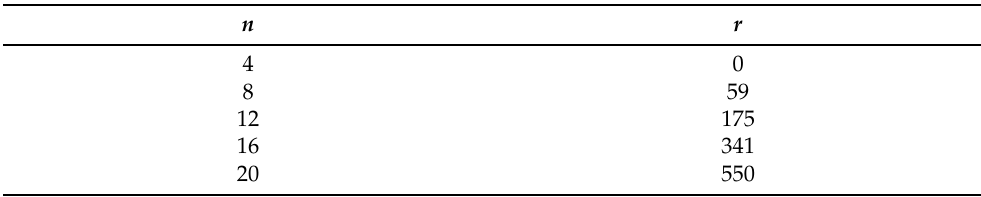
Table 3. Degree Elevation r for Degree n .